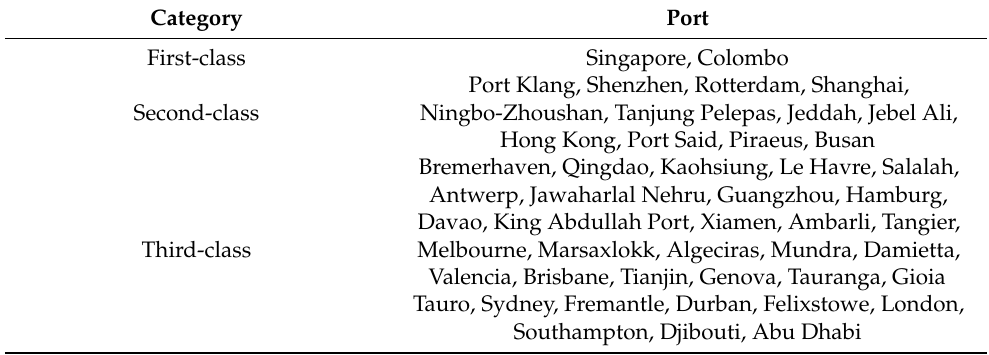
Table 4. Classification results of ports along the MSR based on K-means clustering algorithm. Category